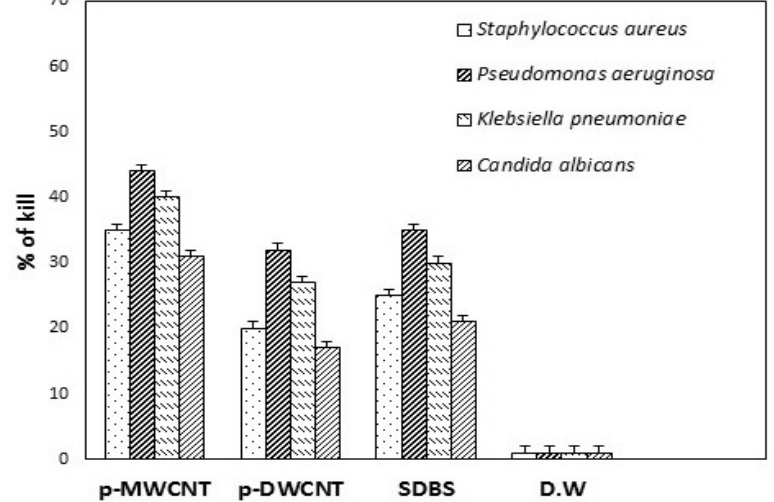
Figure 9. Effect of control samples on the viability of pathogens examined by the colony counting method, after being treated with purified-MWCNT, purified-DWCNTs, and SDBS at a concentration of 100 µg/mL or DW only (UT, untreated) for 24 h for Staphylococcus aureus , Pseudomonas aeruginosa , and Klebsiella pneumoniae and 48 h for Candida albicans .